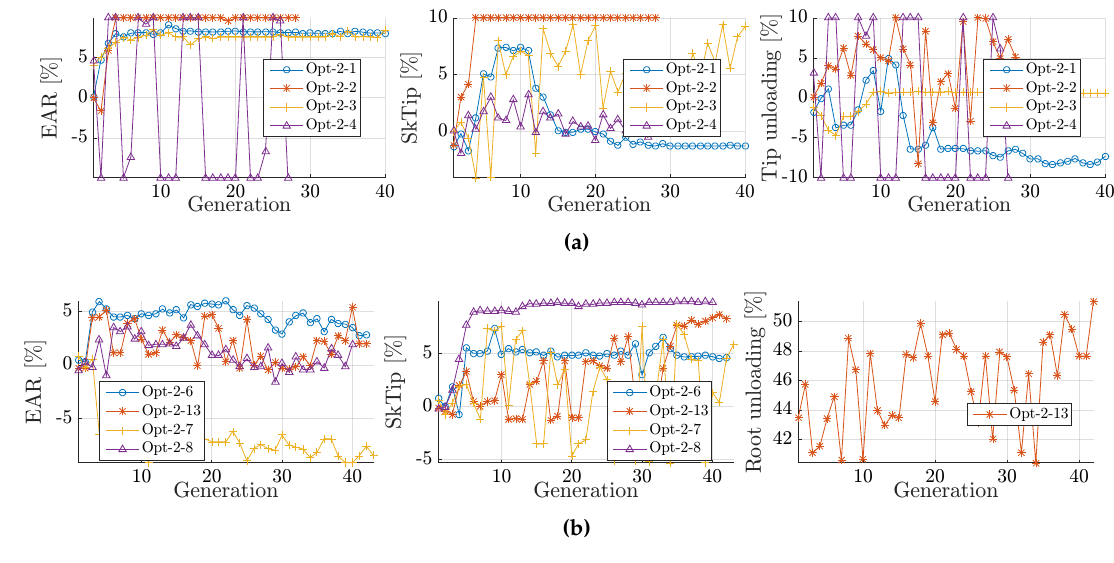
Figure 7. Parameter development, given as median per generation, relative to baseline design. ( a ) Selected geometry parameters of optimisations in Group 1; ( b ) Geometry parameters of optimisations in Group 2.